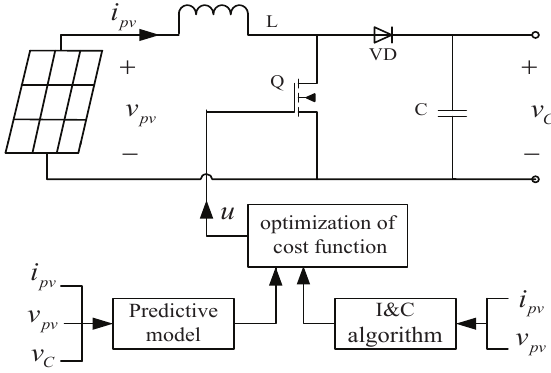
Figure 4. Control system structure of DC-DC boost